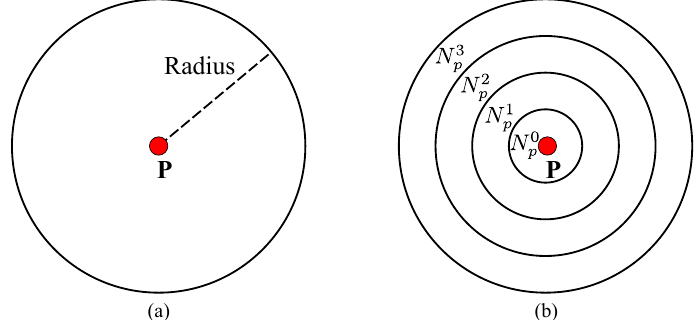
Figure 6. Surrounding neighborhood patch, N